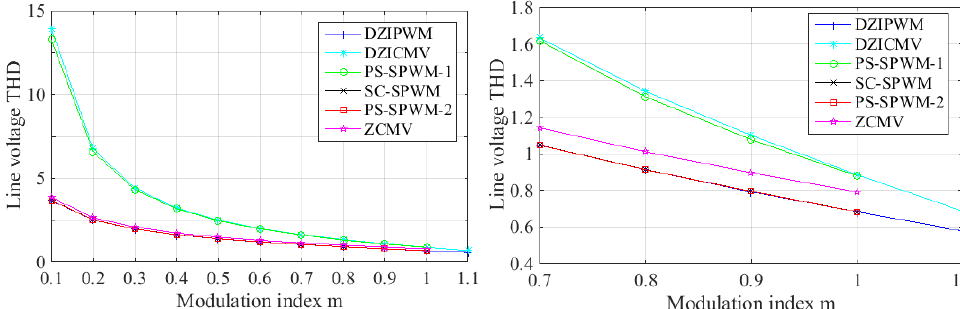
Figure 17. The THD values of line voltage u ab for relative strategies: ( left ) with 0.1 < m < 1.1 ( right ) with 0.7 < m < 1.1.